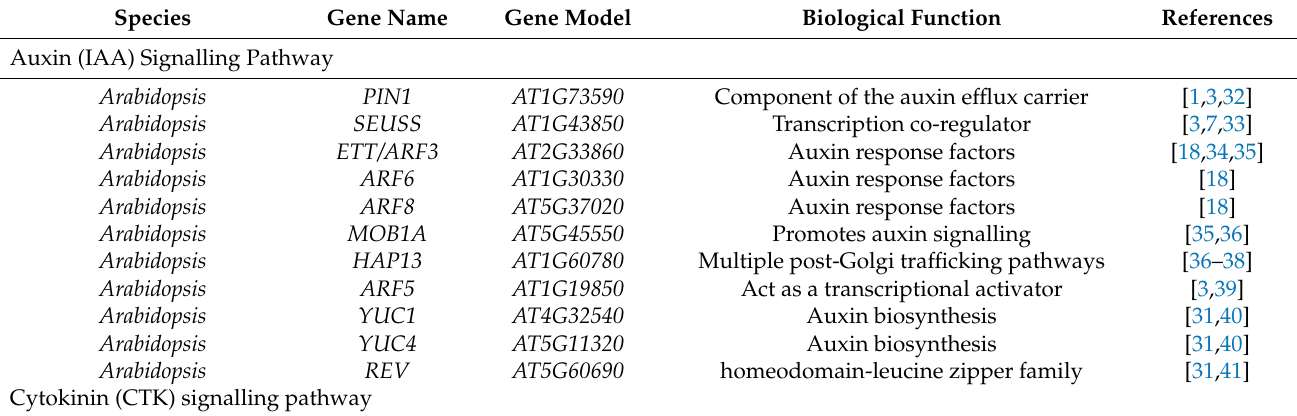
Table 1. The list of key genes of ovule number in